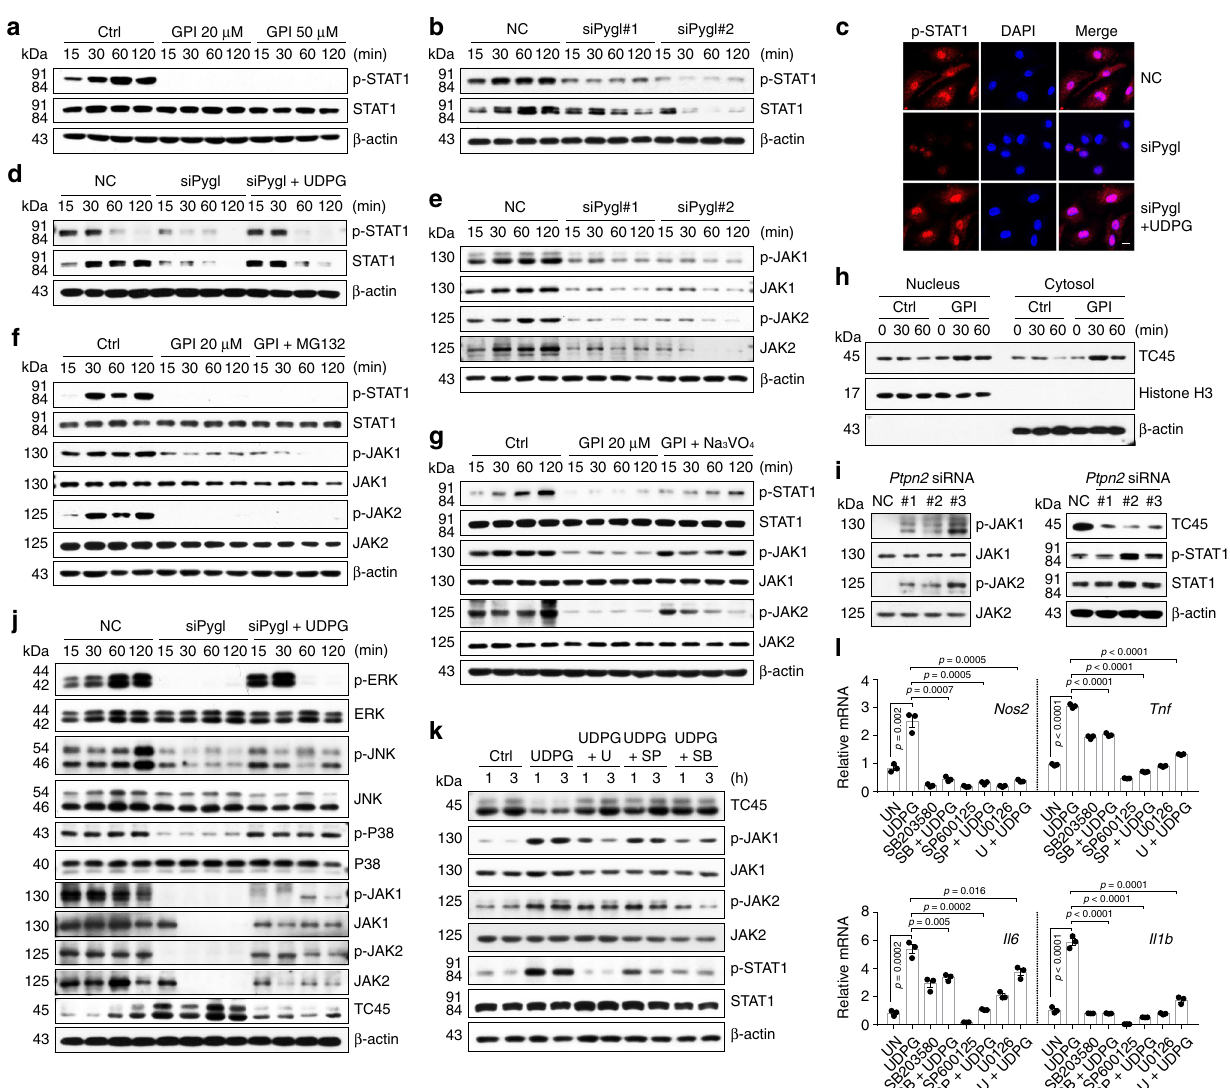
Fig. 6 UDPG-P2Y 14 pathway regulates STAT1 phosphorylation. a , b BMDMs were pretreated with GPI (20 or 50 μ M) for 30 min or pretransfected with Pygl siRNA for 24 h prior to stimulation with IFN- γ /LPS, followed by western blot analysis of STAT1 and its phosphorylation from 15 to 120 min after stimulation. c , d Pygl siRNA transfected BMDMs were treated with IFN- γ /LPS ± UDPG, STAT1 and its phosphorylation was analyzed by two-photon confocal microscope, scale bar, 10 μ m ( c ) and western blot ( d ). e BMDMs were pretransfected with Pygl siRNA for 24 h prior to stimulation with IFN- γ / LPS, followed by western blot analysis of JAK1 and JAK2 from 15 to 120 min after stimulation. f , g BMDMs were pretreated with GPI alone or combined with MG132 ( f ) or Na 3 VO 4 ( g ) for 30 min prior to stimulation with IFN- γ /LPS, followed by western blot analysis of STAT1, JAK1, and JAK2 from 15 to 120 min after stimulation. h BMDMs were pretreated with GPI for 30 min prior to stimulation with IFN- γ /LPS, the cytoplasmic and nuclear protein fractions were blotted for TC45, β -actin (cytoplasmic marker) and Histone H3 (nuclear marker). i Ptpn2 siRNA transfected BMDMs were stimulated with IFN- γ /LPS, STAT1, JAK1, JAK2, and TC45 were analyzed by western blot. j Pygl siRNA transfected BMDMs were stimulated with IFN- γ /LPS ± UDPG, ERK, JNK, P38, JAK1, JAK2, and TC45 were analyzed from 15 to 120 min after stimulation by western blot. k , l IFN- γ /LPS stimulated BMDMs were treated with UDPG alone or combined with U0126, SP600125 or SB203580 for 1 and 3 h, JAK1, JAK2, STAT1, and TC45 were analyzed by western blot ( k ). Nos2, Tnf, Il6, and Il1b expression was determined by real-time PCR ( l ). Data are presented as mean ± SEM of n = 3 biologically independent experiments. P values were calculated using one-way